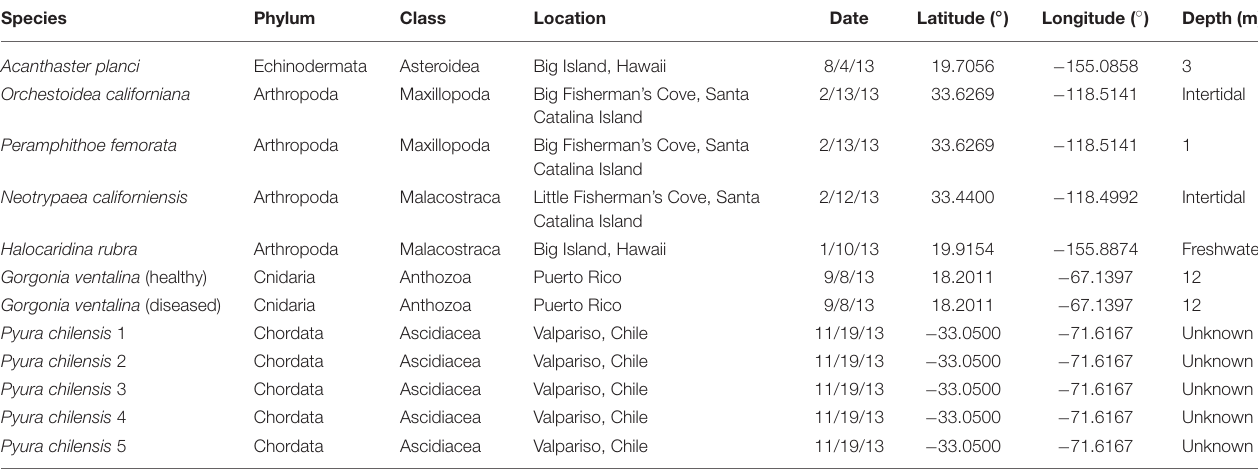
TABLE 1 | Sample details for Arthropoda, Echinodermata, Chordata, and Cnidaria samples used in metagenomic analyses.